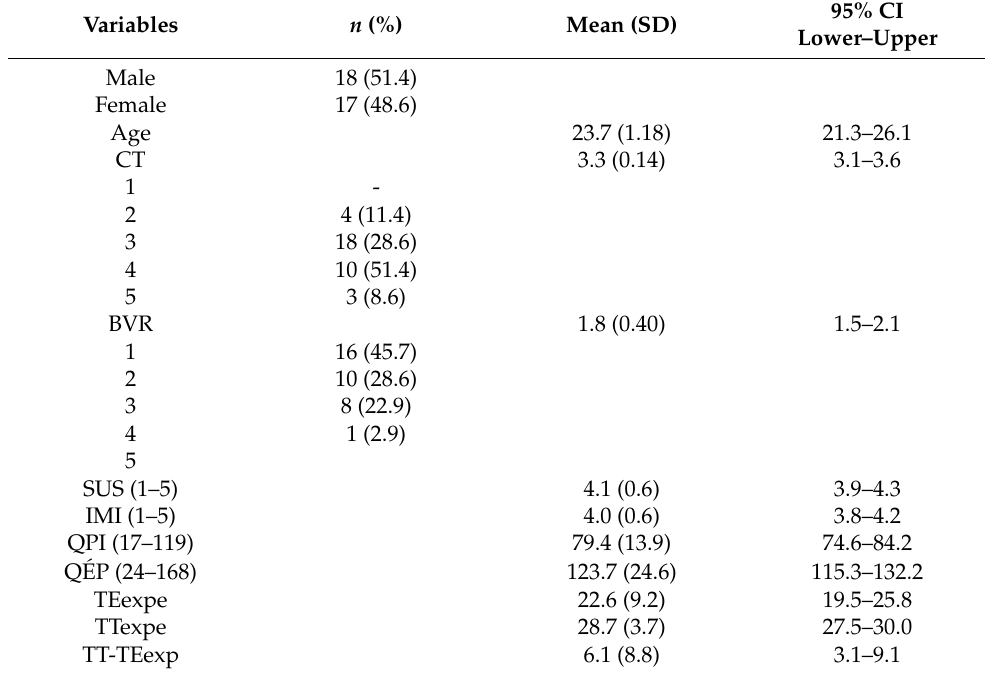
Table 2. Descriptive statistics of age, technological knowledge, background in virtual reality, usability, experience, immersive tendency, presence, and time estimated/effective gaming performance in virtual